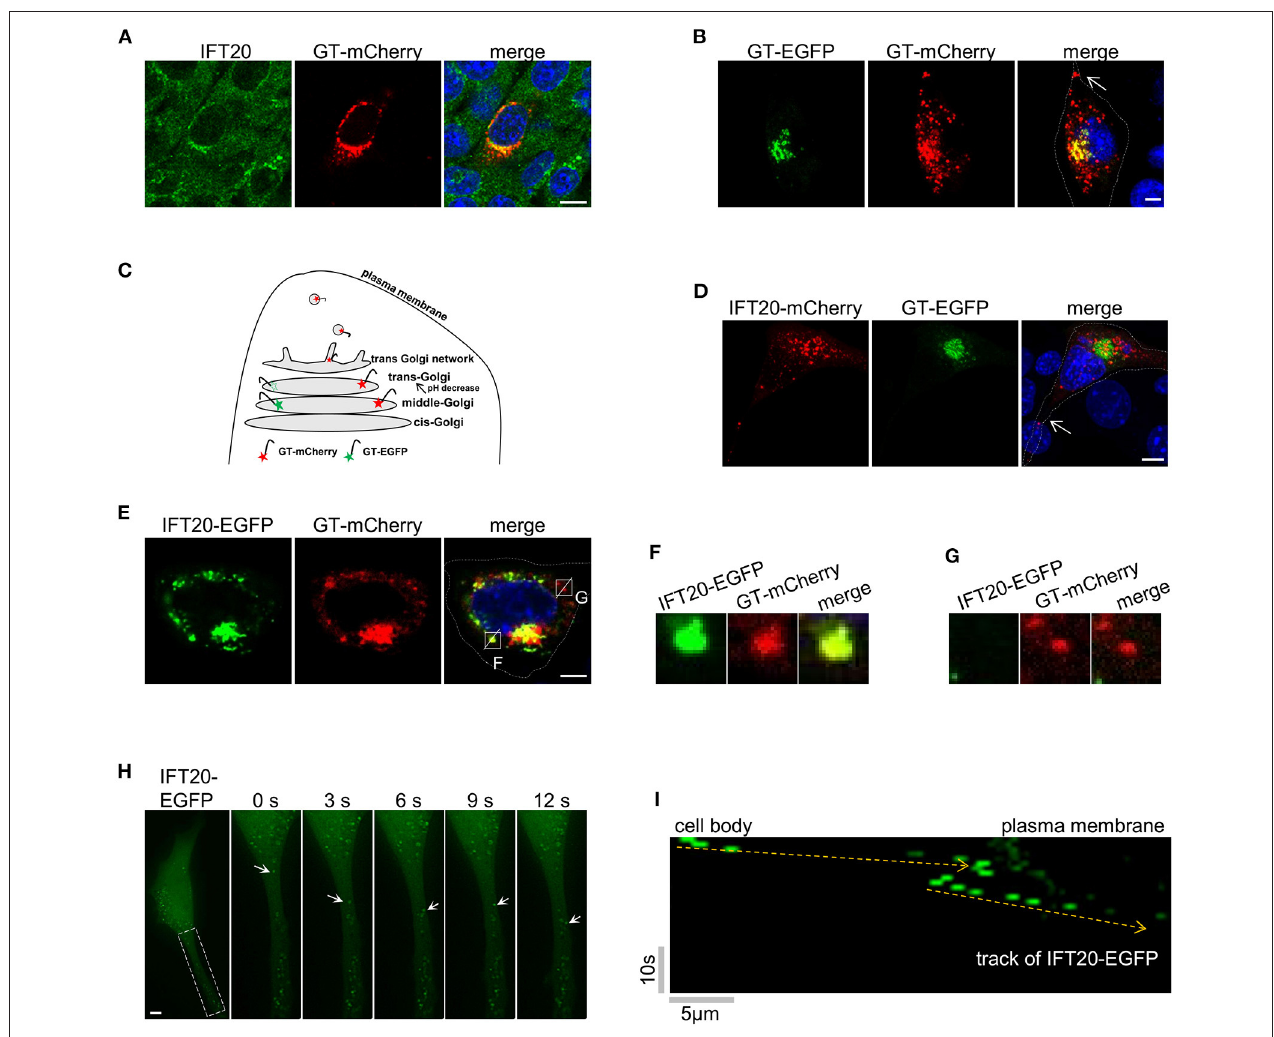
FIGURE 4 | IFT20 localizes at the trans-Golgi, TGN, and in the post-Golgi vesicles. (A) Representative fluorescent images of 4T1 cells expressing GT-mCherry and stained with IFT20 antibodies showed that IFT20 localized at the Golgi. (B) Representative fluorescent images of 4T1 cells expressing GT-EGFP and GT-mCherry showed that GT-EGFP labels the middle-Golgi and GT-mCherry labels the middle-Golgi, trans-Golgi, and some dot signals; arrow indicates the dot signal of GT-mCherry in cell protrusion. (C) Schematic illustrating the markers used to distinguish the middle-Golgi and trans-Golgi based on their sensitivity to pH. EGFP and mCherry fluorophores were directed to the lumen of the middle-Golgi and trans-Golgi by fusing with the Golgi targeting domain of β -1,4-galactosyltransferase (GT). The fluorescence of EGFP disappeared as a result of the lower pH at the lumen of the trans-Golgi compared with middle-Golgi, whereas mCherry fluorescence was stable. In 4T1 cells, GT-mCherry was also found at the TGN and in the post-Golgi vesicles. (D) Representative fluorescent images of 4T1 cells expressing GT-EGFP and IFT20-mCherry showed that IFT20 did not localize at the middle-Golgi; arrow indicates the dot signal of IFT20-mCherry in cell protrusion. (E) Representative fluorescent images of 4T1 cells expressing IFT20-EGFP and GT-mCherry showed that IFT20 colocalized with GT-mCherry not only at the trans-Golgi/TGN, but also in the post-Golgi vesicles. (F,G) Magnified views of the indicated insets in (E) showing complete colocalization (F) or no-colocalization (G) between IFT20-EGFP and GT-mCherry post-Golgi vesicles. The white dotted lines mark the entire cell profile. (H) Representative time-lapse images showing dynamic transport of IFT20-EGFP in cell protrusion. S, second. (I) The kymograph from a representative dot signal of IFT20-EGFP indicated by the arrows in (H) . Yellow dashed lines indicate the track of IFT20-EGFP. Horizontal scale bar is 5 µ m; vertical bar is 10s. All fluorescent experiments were performed two (A,H) or three times (B,D,E) . The nucleus was stained by DAPI (blue). Scale bar, 5 µ